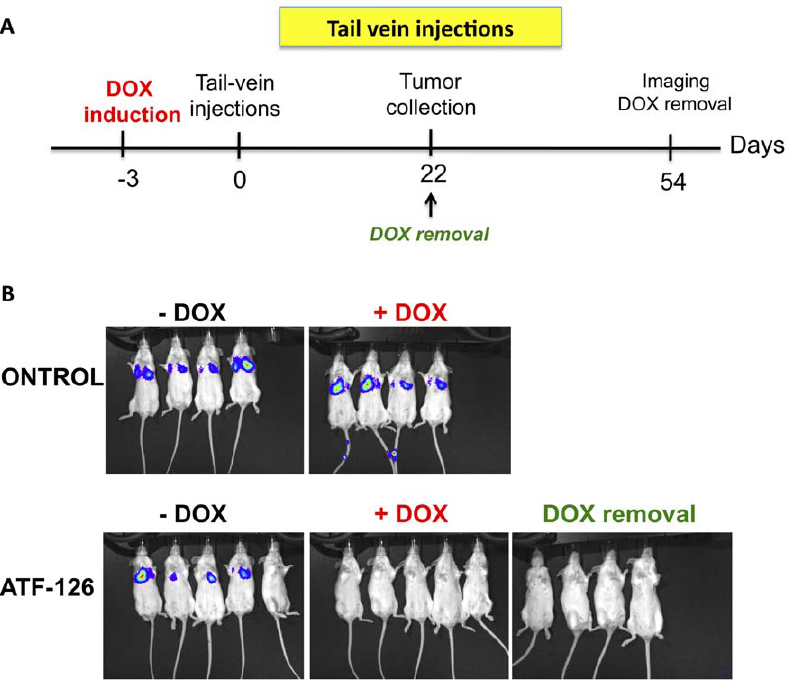
Figure 4. ATF-126 inhibits breast tumor cell colonization in the lungs. A. Time-line of the tail-vein injections experiments, indicating the times of the DOX induction and removal, and tumor collection. B. Bioluminescence images of CONTROL and ATF-126 mice groups maintained in DOX-free ( 2 DOX, left panel) and DOX containing diet ( + DOX, right panel). Mice were injected via tail-vein with either CONTROL or ATF-126 cells and imaged every week to assess lung colonization. Images shown were taken at day 22 after injection of the tumor cells. DOX removal indicates ATF-126 animals previously induced by DOX and next placed in DOX-free diet.